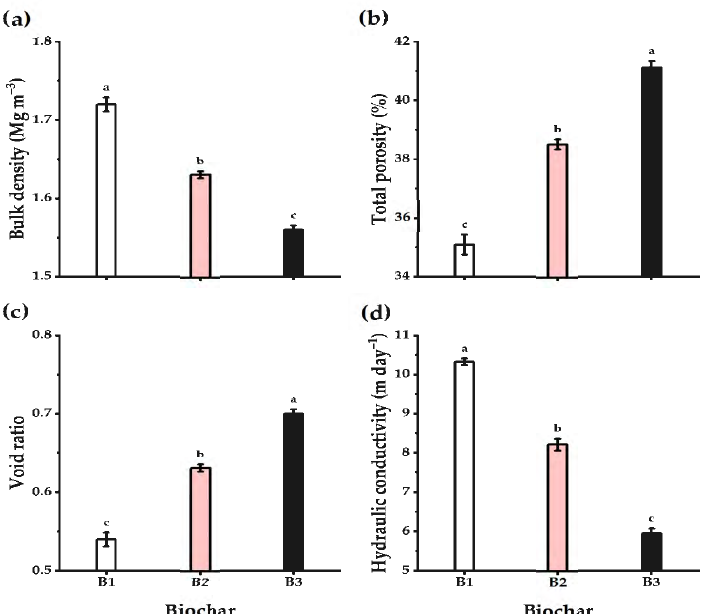
Figure 5. Effect of three levels of biochar soil supplementation (0 (B 1 ), 7.5 (B 2 ), and 15 t ha − 1 (B 3 )) on the physical properties of soil cultivated with wheat at the harvest stage in sandy soil. ( a ) Bulk density (Mg m − 3 ), ( b ) total porosity (%), ( c ) void ratio, and ( d ) hydraulic conductivity (m day − 1 ). Bars and error bars represent the means ± SE, respectively, of three biological replicates. Different letters reveal statistically significant differences among treatments.